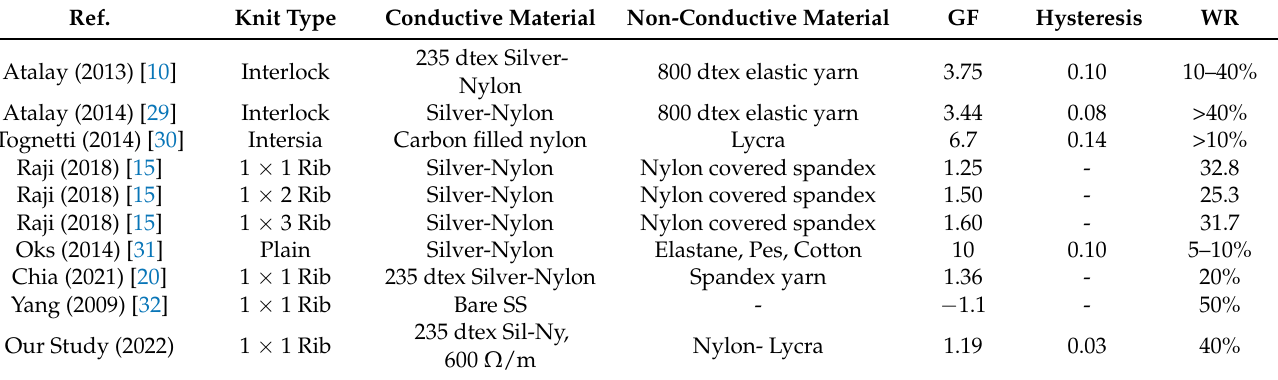
Table 5. The performance comparison of previous literature studies and this